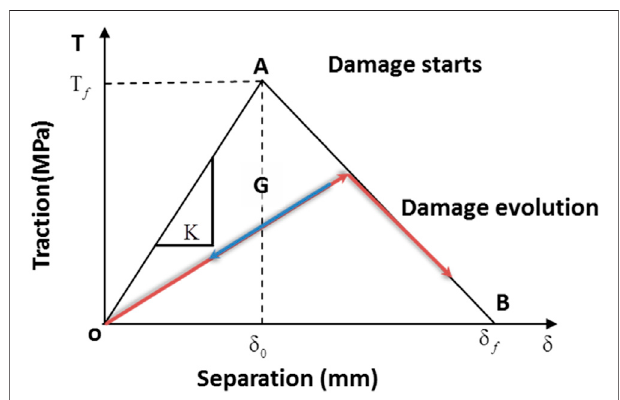
FIGURE 7 | Linear damage evolution of the traction – separation model.